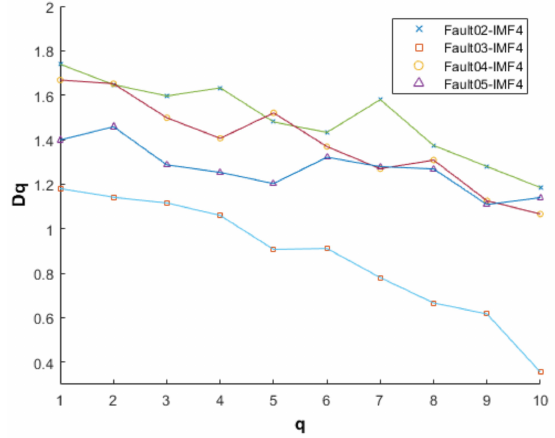
Figure 25. IMF4‑VMD box fractal dimension